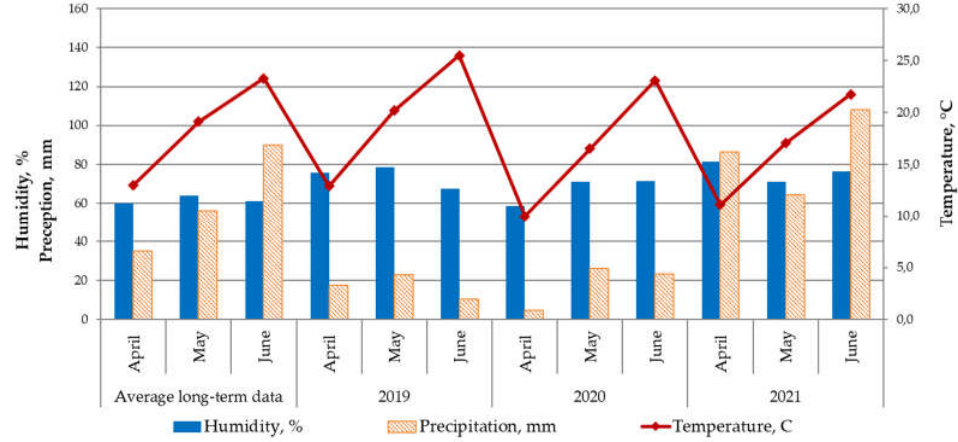
Figure 1. Climatogram of weather conditions for the research period 2019–2021 (according to the FRCBPP meteorological station, Russian Federation, Krasnodar region, Krasnodar).